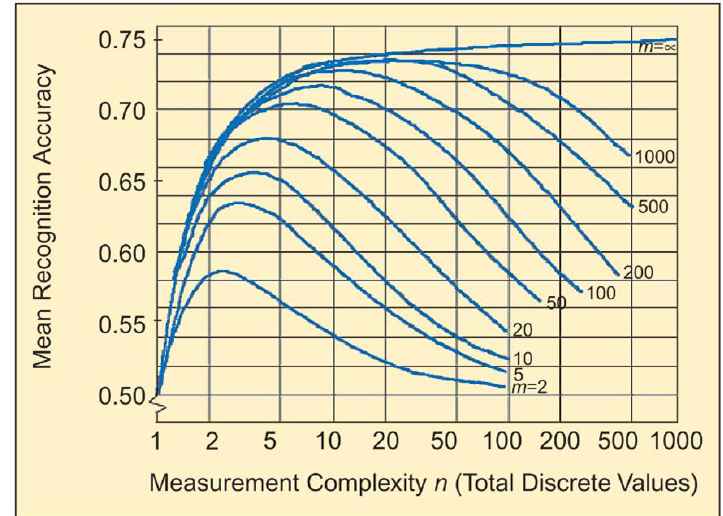
Figure 12. The relationship between data complexity, training set size and mean classification accuracy. Complexity is here calculated as the number of bands raised to the exponent of the number of possible DN values per band (2 # of bits). For HSI (and MSI with many bands), huge training sets would be required to obtain adequate classification accuracies if all bands are used. m = training set size. © 2002 IEEE. Reprinted, with permission, from Landgrebe, D. (2002), Hyperspectral image data analysis, IEEE Signal Processing Magazine [286].